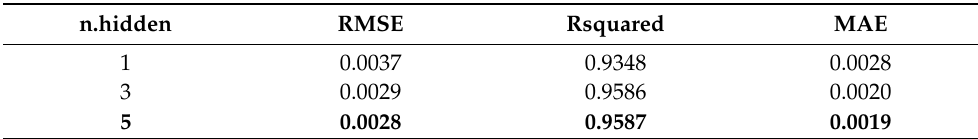
Table 4. Quantile regression neural network. n.hidden